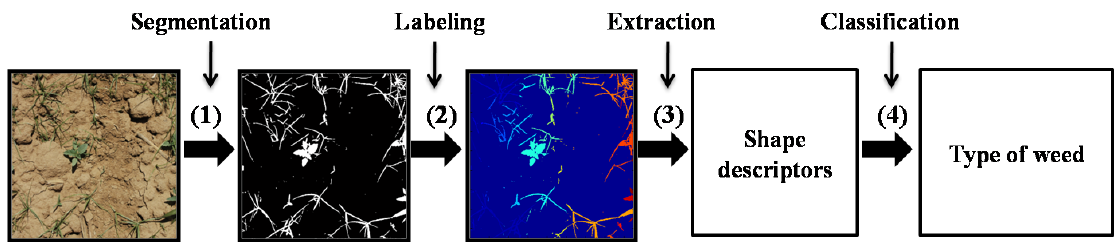
Figure 3. The proposed approach consists of four